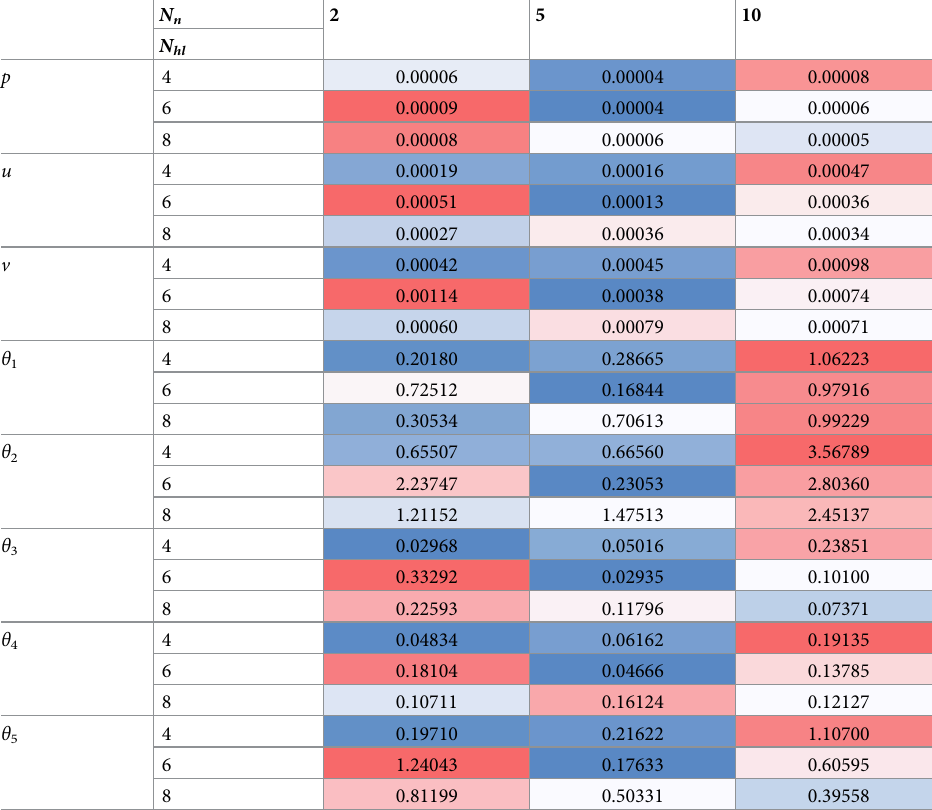
, and different num- hl